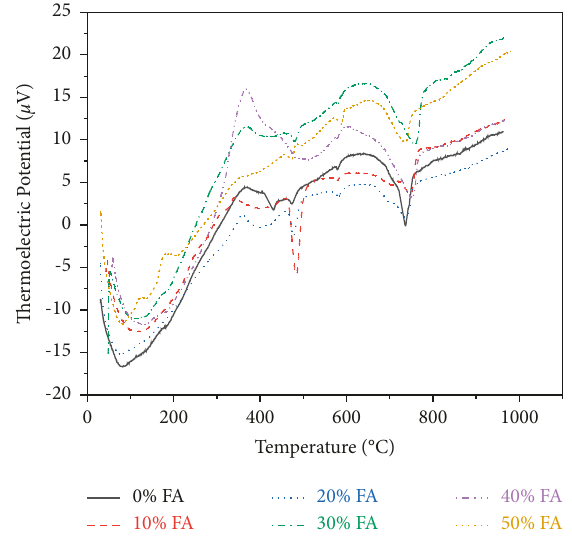
Figure 5: DTA curves of different experimental conditions.